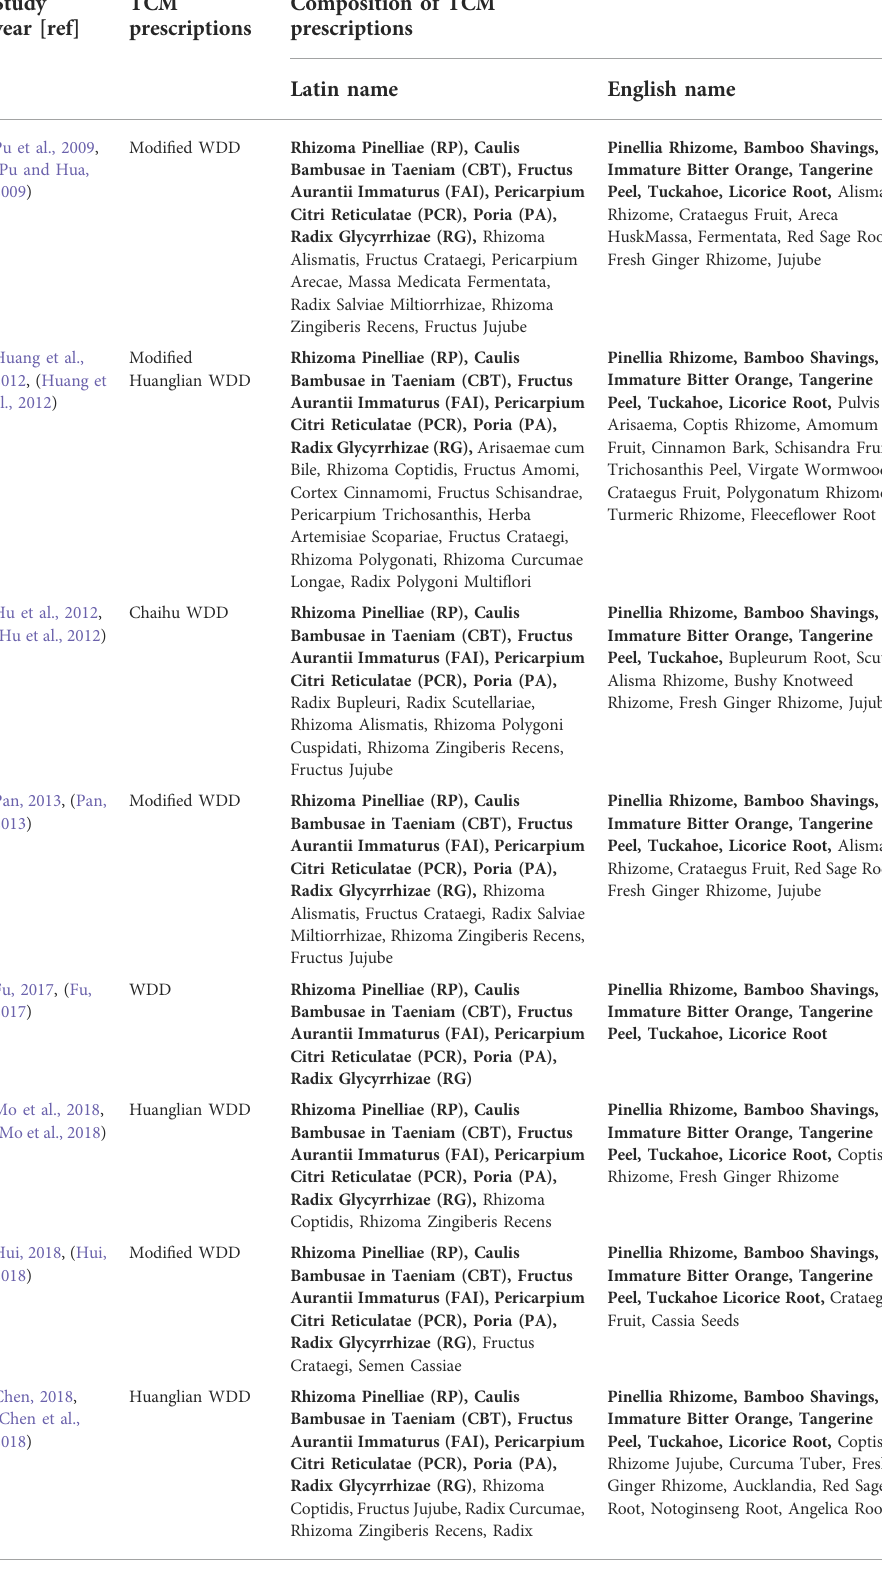
TABLE 2 Composition of the TCM